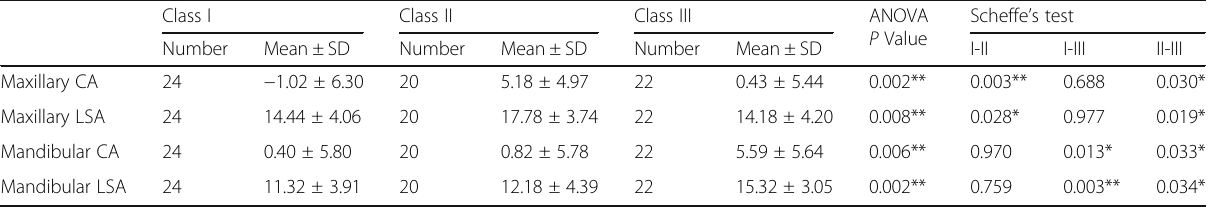
Table 3 Collum angle/labial surface angle of central incisors among different sagittal skeletal malocclusions (°)